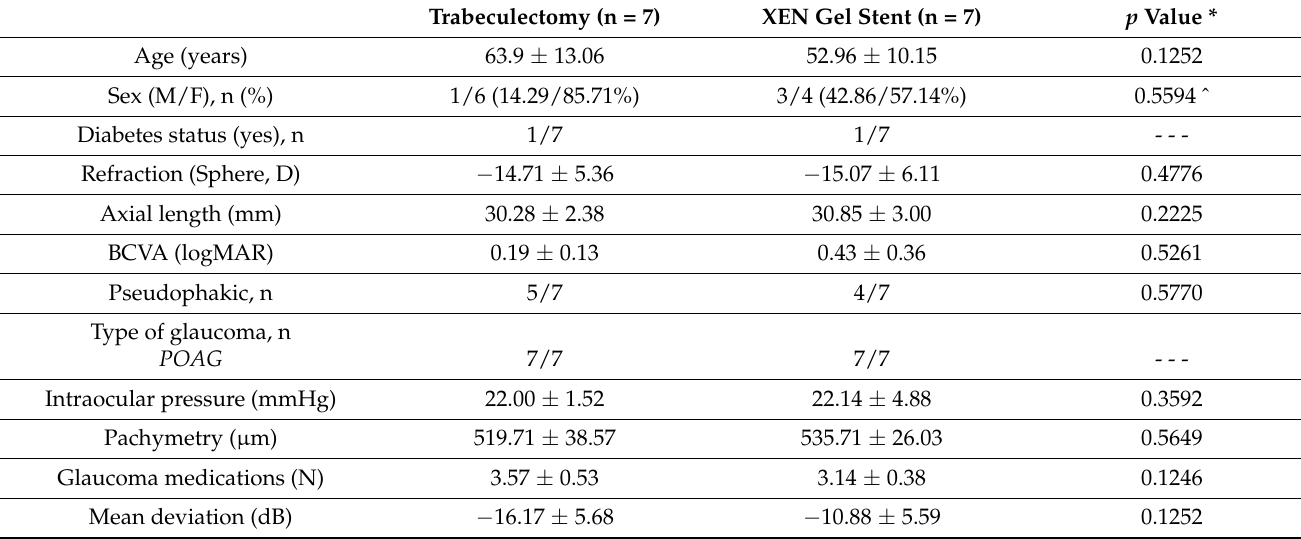
Table 1. Preoperative data.